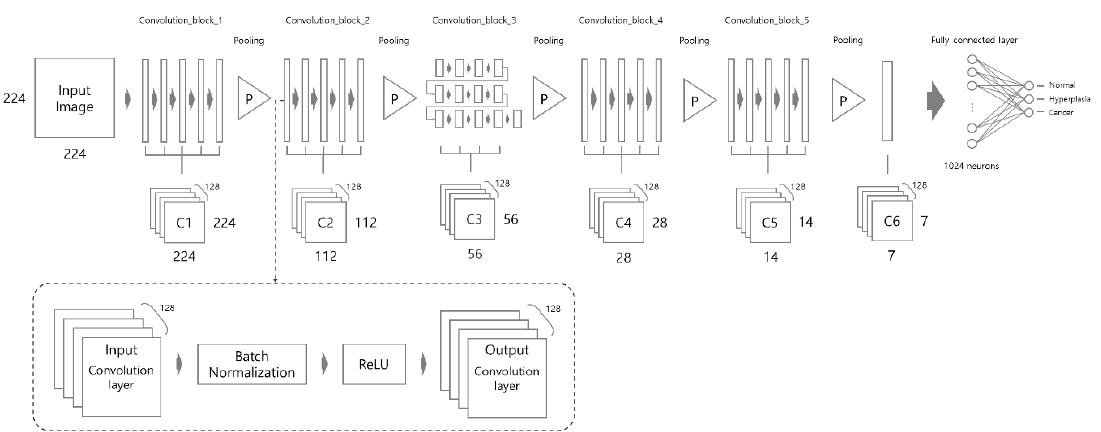
Figure 4. Proposed network architecture. Note that each long rectangle means “convolution